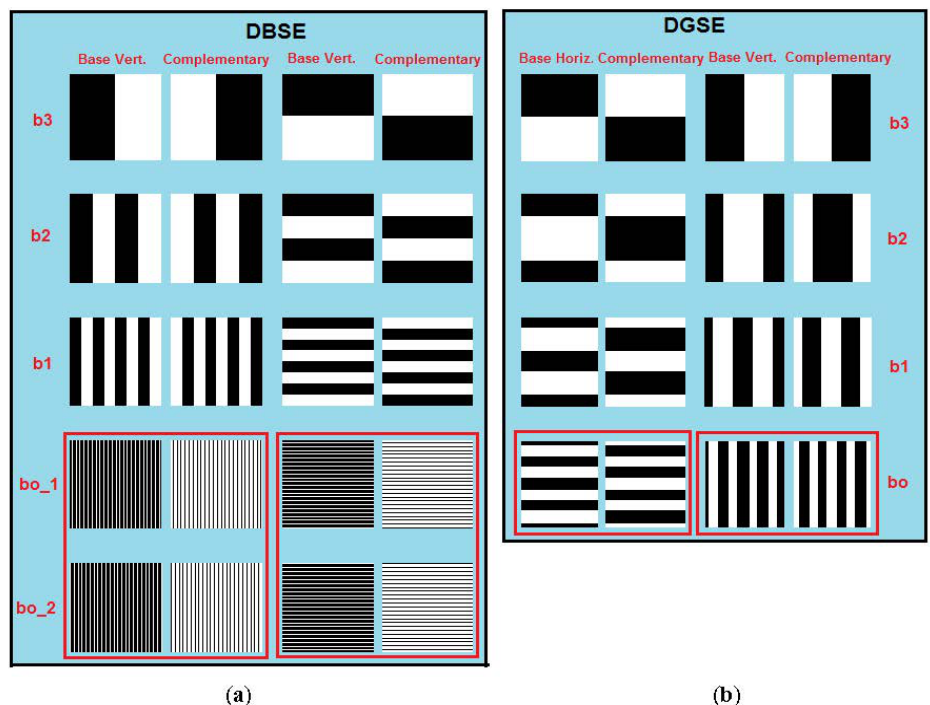
Figure 3. ( a ) DBSE and ( b ) DGSE scanning image patterns with a number of